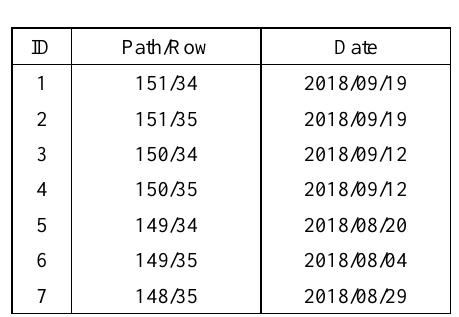
Figure 2. Study area (A, C are for training, B is for